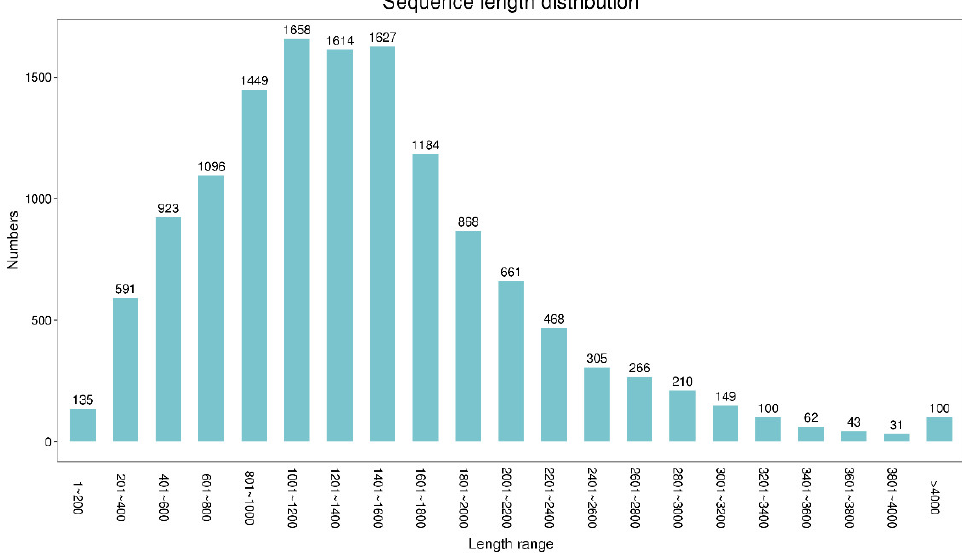
Figure 1. Sequence length distribution of CDS.